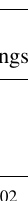
Table 3. PALM domain configuration for the case